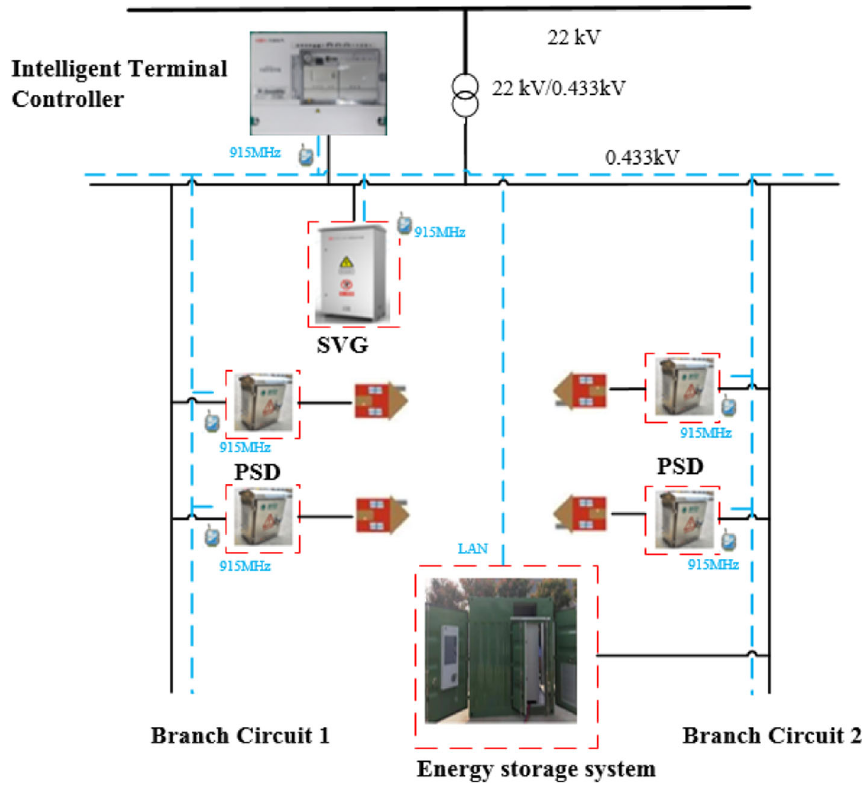
Fig. 6 Schematic diagram of engineering application site configuration